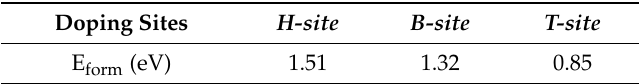
Table 1. Doping formation energy of Ag-doped graphene surface.